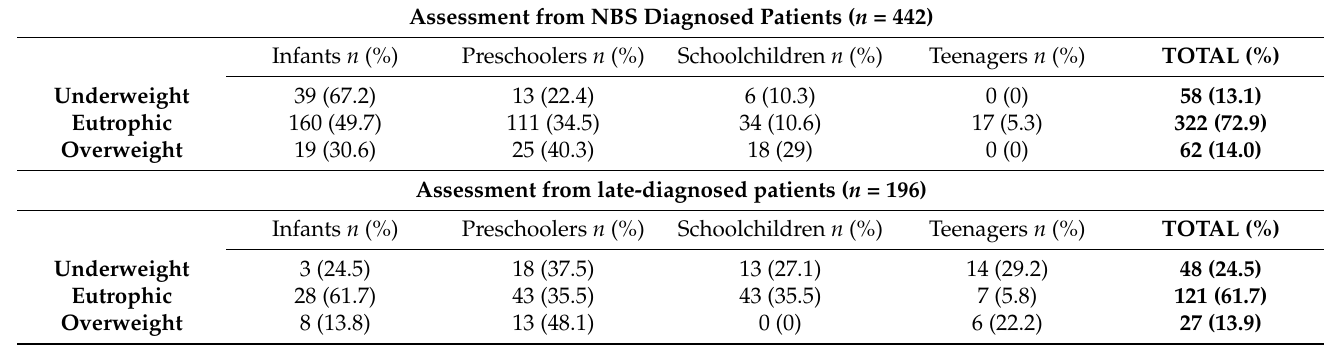
Table 1. Assessments from HPA/PKU patients by type of diagnosis, age and BMI Z-Score classification.